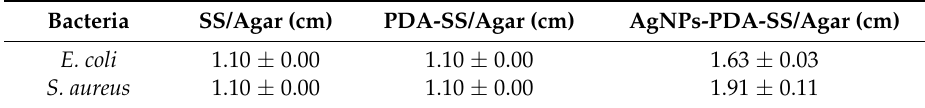
Figure 7. The inhibition zones of SS/Agar, PDA-SS/Agar, AgNPs-PDA-SS/Agar films against E. coli ( a ) and S. aureus ( b ). Red dotted circle represents the edge of the inhibition zone. Table 1. Diameters of the inhibition zones of SS/Agar, PDA-SS/Agar and AgNPs-PDA-SS/Agar films against E. coli ( a ) and S. aureus ( b